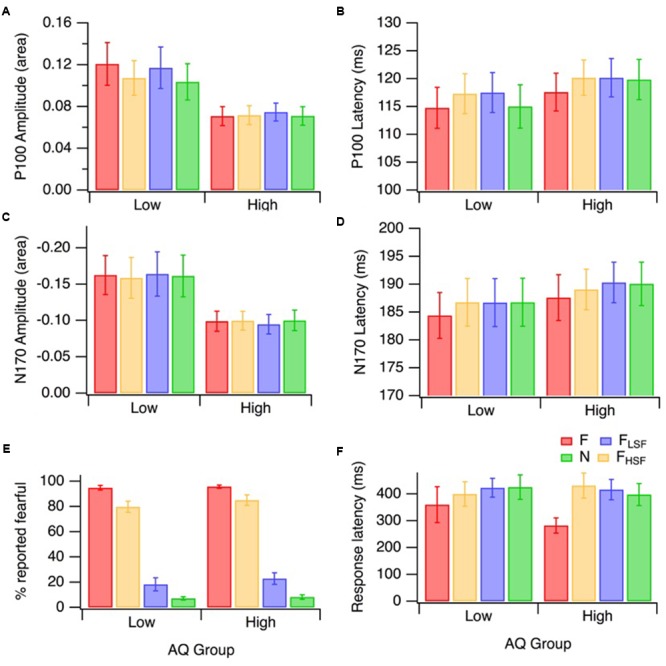
Mean ERP and behavioral responses for the low (n = 16) and high (n = 17) AQ groups to the different hybrid face sets: FLSF–FHSF (red), NLSF–NHSF (green), FLSF–NHSF (blue), and NLSF–FHSF (orange). The error bars on all panels represent ±1 SE. P100 amplitudes and latencies are displayed in (A) and (B). N170 amplitudes and latencies are displayed in (C) and (D). Behavioral results for the percentage of trials in which fear was identified, and the associated reactions times are presented in (E) and (F), respectively.